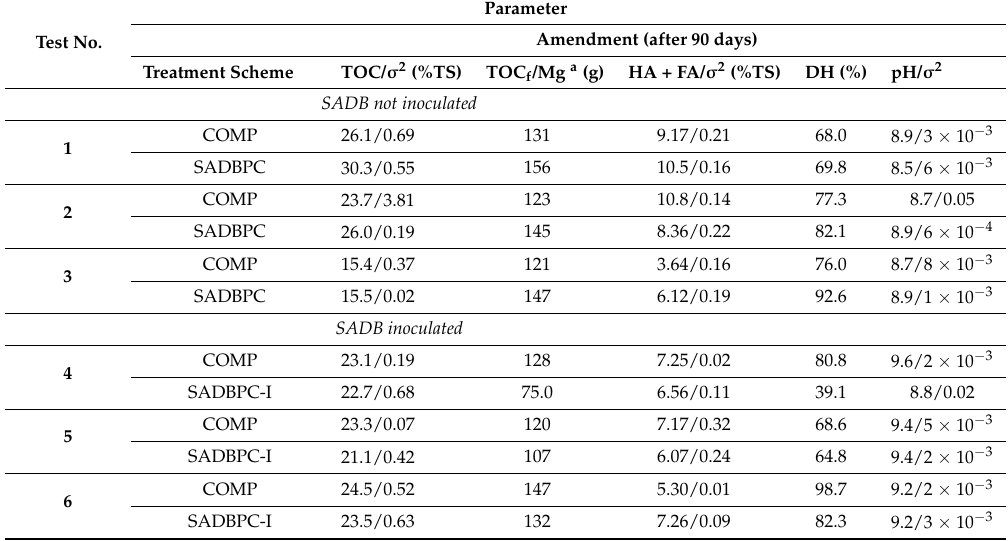
Table 5. Total organic carbon (TOC), humic acids (HA) + fulvic acids (FA), degree of humidification (DH), and pH of the amendment at the end of the COMP and integrated SADBPC or SADBPC-I processes with relative variances ( σ 2